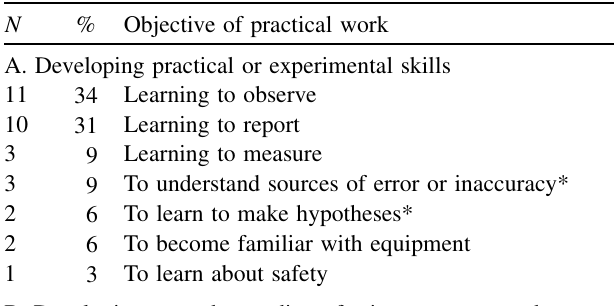
TABLE II. Objective categories for practical work in preser- vice teachers’ essays ( n ¼ 32 ). The number in the first column is the number of preservice teachers that suggested this item as an objective for practical work. The second column represents the proportion of preservice teachers (as percentages) emphasizing this item in this study. Objectives that belong to several main categories are denoted with an